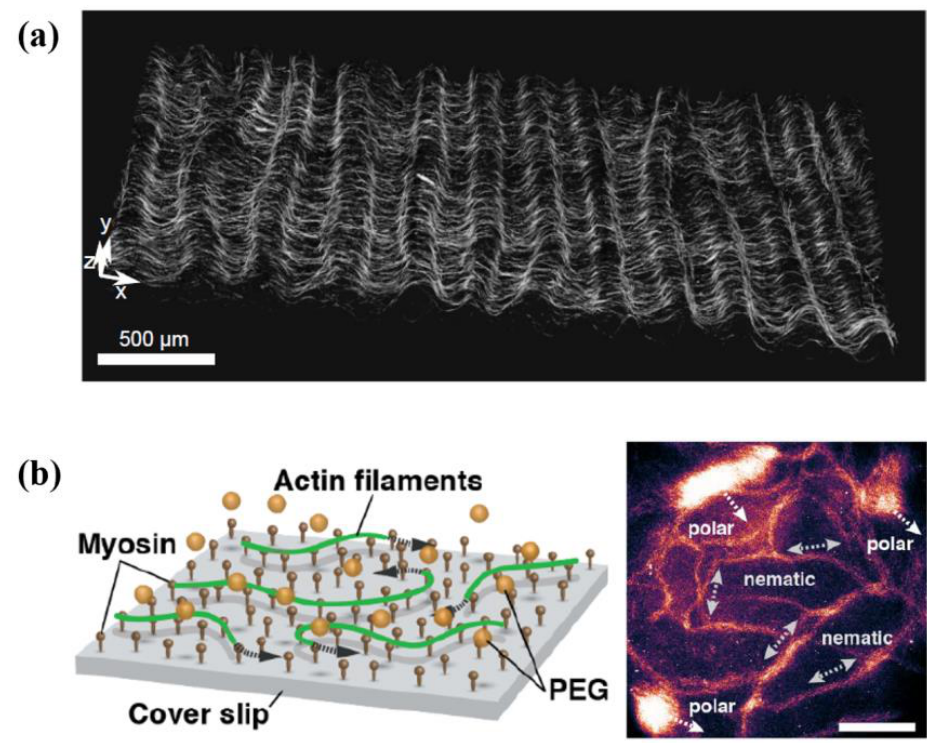
Figure 1. Some behaviors exhibited in reconstructed cytoskeletal filament (RCF) systems. ( a ) A corrugated sheet consists of RCFs in the flow cell. Reprinted with permission from Reference [16], Copyright 2019, National Academy of Sciences. ( b ) The schematic of cytoskeletal filaments gliding experiment and coexistence of polar and nematic phases. Scale bar, 100 µm. Reprinted with permission from Reference [17] , Copyright 2018, American Association for the Advancement of Science.